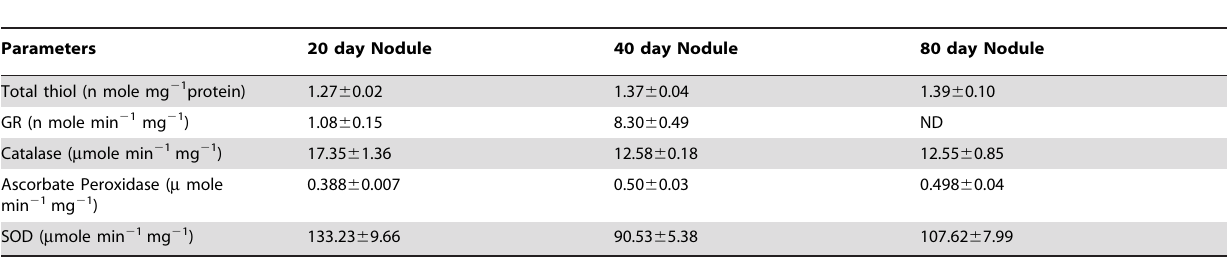
Table 1. Measurement of total thiol, Glutathione reductase (GR), Catalase, Ascorbate Peroxidase and Superoxide dismutase (SOD) activity in different days’ nodule extracts of A. hypogaea